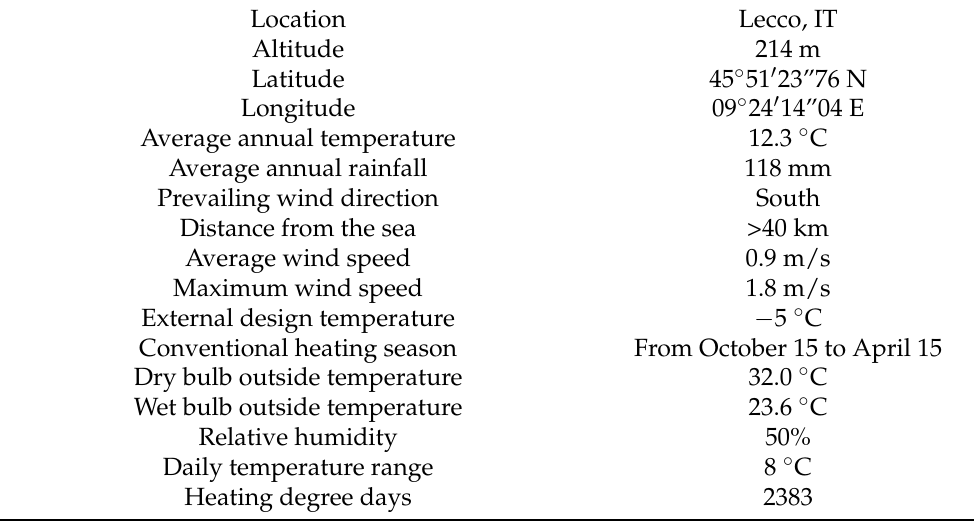
Table 7. Key data on the location of the office Building 8 of Politecnico di Milano, Lecco